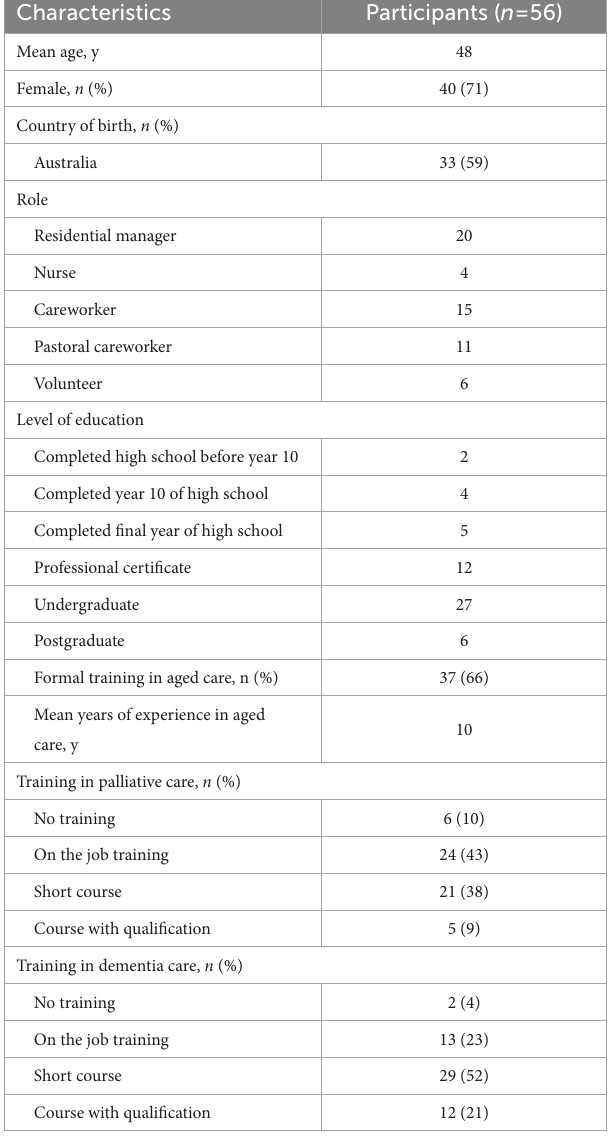
TABLE 1 Participant